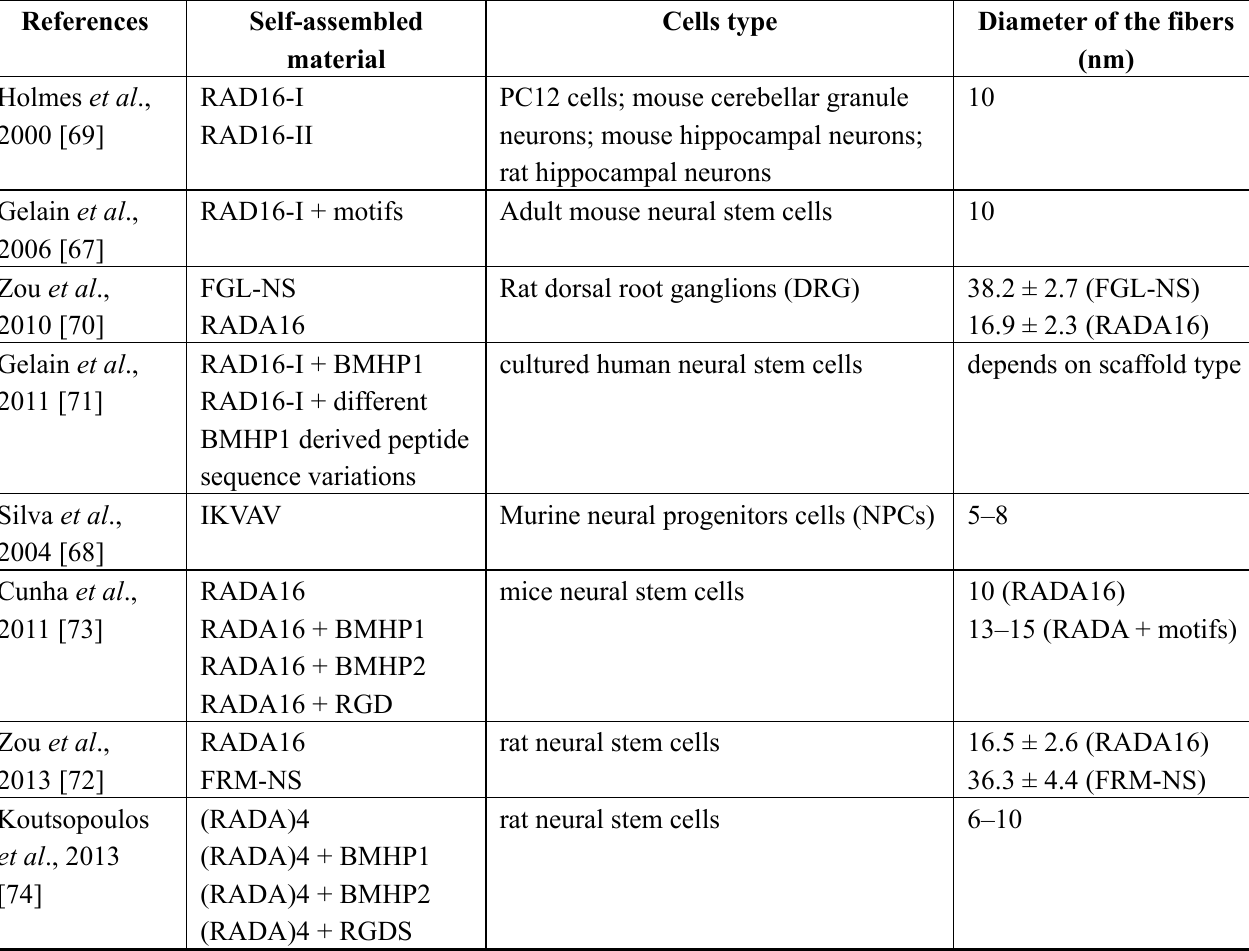
Table 6. In vitro studies on self assembling materials: main